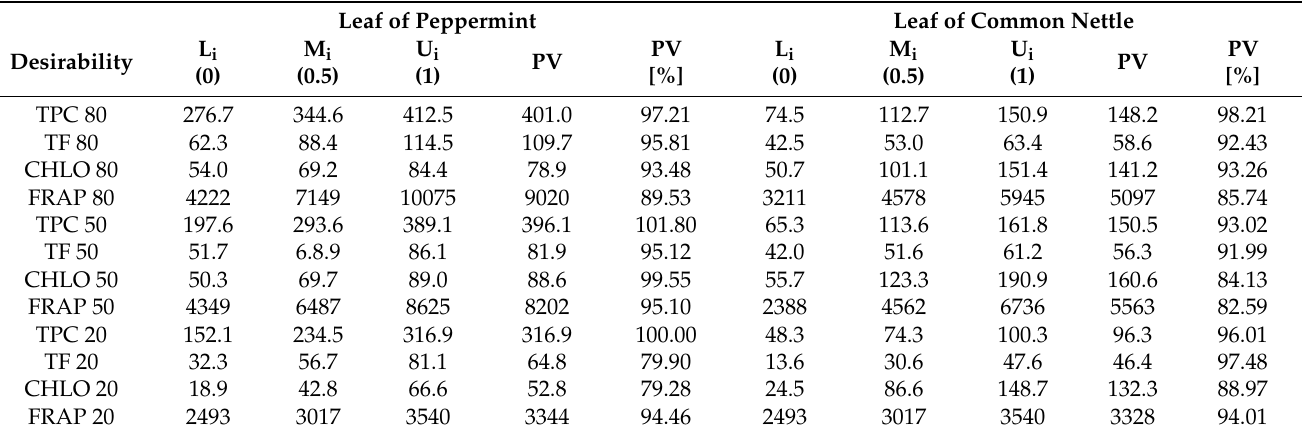
Table 5. Optimum conditions of